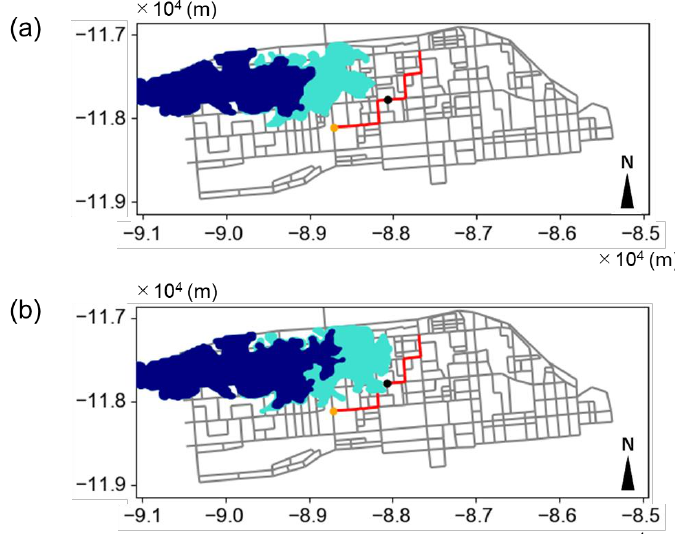
Figure 5. Criteria for disaster assessment: ( a ) evacuation success; ( b ) evacuation failure. Blue shows the inundation area at the start of the evacuation; light blue shows the inundation area at the time the evacuees walked to the point of the black dot. The red line marks the evacuation route. The x- and y-axes indicate the axis in the Japan Plane Rectangular Coordinate System Xll.